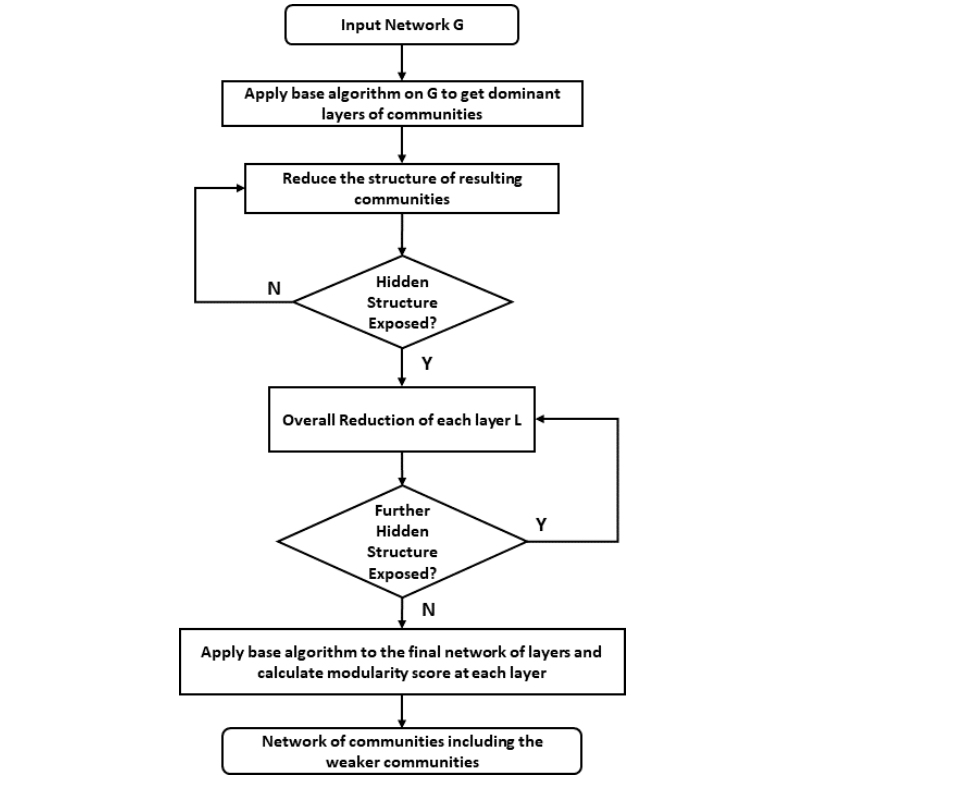
Figure 3. The flowchart illustration of the operation of the hidden community detection (HCD) method.